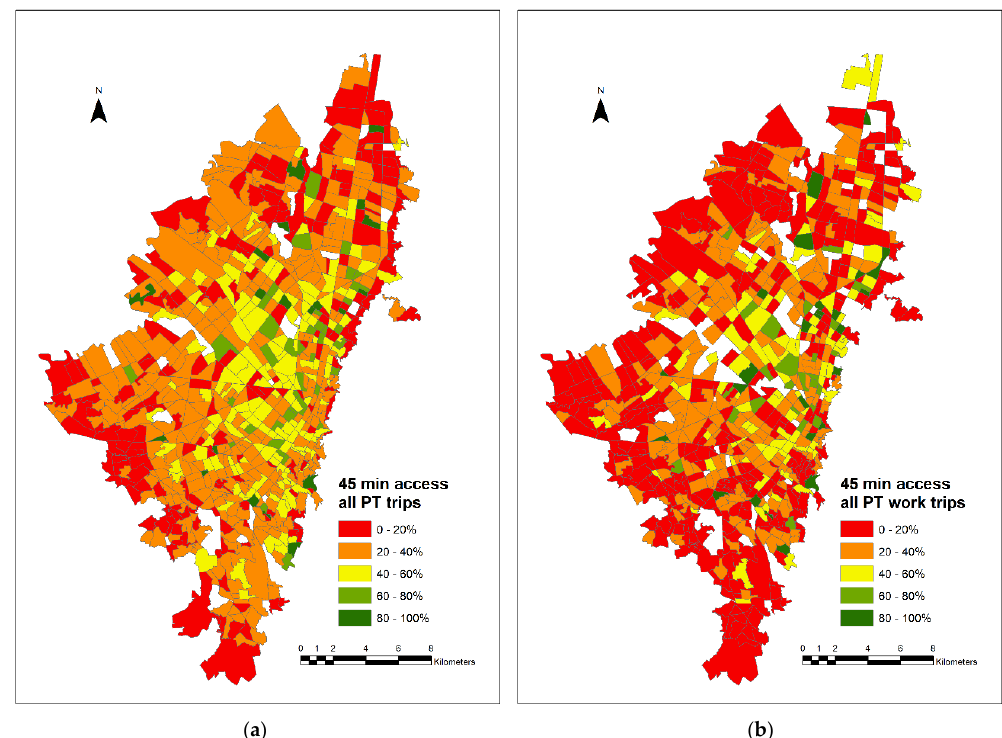
Figure 5. The proportion of people who reach their activity location within 45 min by public transport (PT), for all trip purposes ( a ) and for work trips ( b